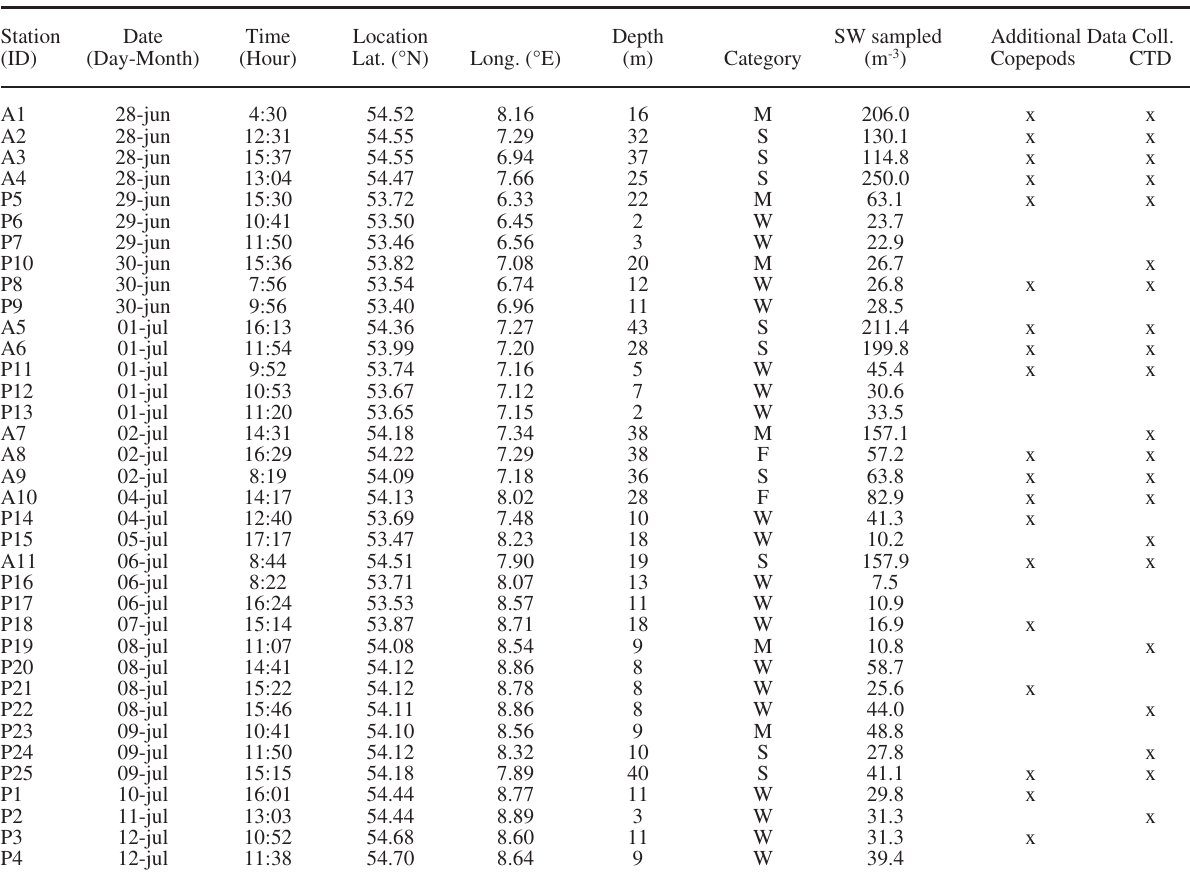
Sampling stations were partitioned into four dif- ferent categories: 1) offshore vertically mixed, 2) tidal mixing zone (TMF), 3) stratified water and 4) Wadden Sea vertically mixed. The first three categories were based on the stratification variable ( f ) derived from vertical density profiles r(z) (Simpson et al ., 1979). The value of f represents a measure of the amount of energy required to mix the water column and thus increases with increasing water column stratification (mixed wa- ters <10 J m -3 , frontal waters 10-20 J m -3 and stratified waters >20 J m -3 ) (Lee et al ., 2007). The Wadden Sea is a flat high-energy system separated from the North Sea by a row of barrier islands and sandbanks. Deep tidal channels form the connection between the North Sea and Wadden Sea. Within the Wadden Sea these channels branch into numerous gullies and creeks. During ebb tides, vast areas of tidal flats emerge and, at low tide about two third of the bottom of the Wad- den Sea is exposed. The limits of the Wadden Sea were defined by the 10-m water depth profile along the Ger- man coast offshore of the